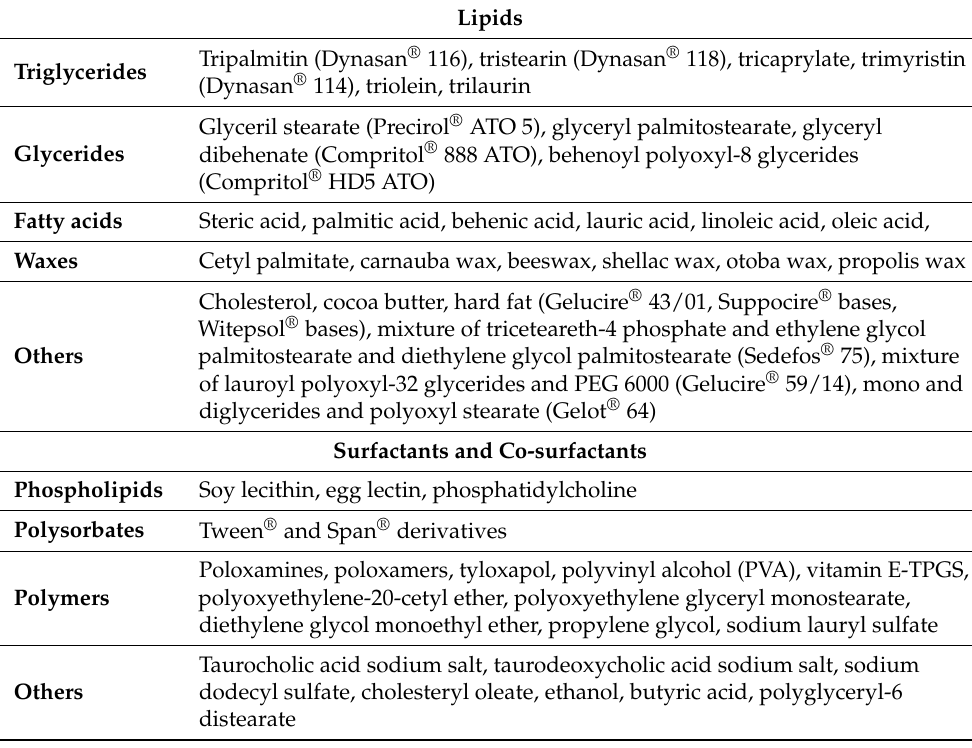
Table 1. Commonly used components for SLNs preparation.